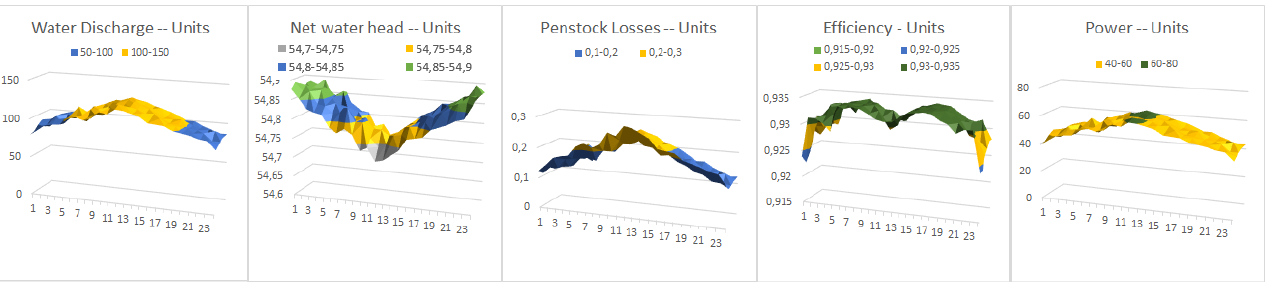
Figure 17. CRO-SL with (DEB/DER) and Gaussian Mutation substrates— CRO ( 3 r ,4 ) . Results of Water discharge (m 3 /s). Net water head (m). Penstock (m). Efficiency (%) and Power generated (MW/h). Daily dispatch (24